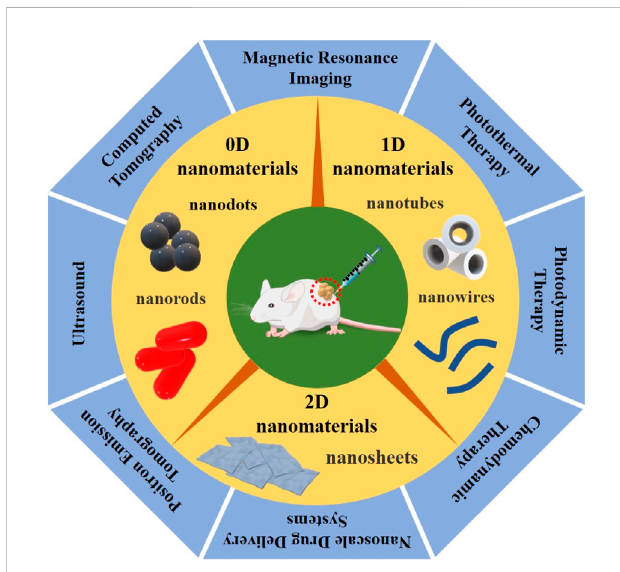
FIGURE 1 Graphical summarization of the three types of LDNs, according to dimensionalandstructurecharacteristics,dividedinto0Dnanomaterials (such as quantum dots and nanorods), 1D nanomaterials (such as nanowires and nanotubes), and 2D nanomaterials (such as nanosheets), combined with the novel therapeutic methods and imaging techniques, including PTT/PDT/CDT/NDDS and MRI/US/PAI/ CT/PET, which have great promise for imaging-guided non-invasive cancer